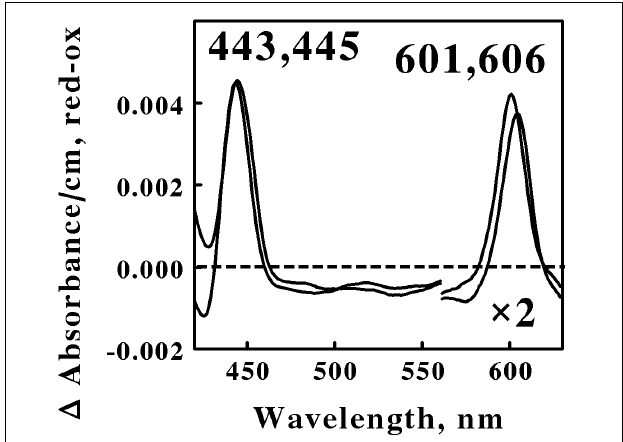
FIGURE 4 | Reduced minus oxidized difference spectra obtained when excess ferrous sulfate was mixed with intact cells of Acidiplasma aeolicum (lower wavelengths) and Ferroplasma acidiphilum (higher wavelengths), representing the Euryarchaeota. The number of cells present in 8 ml were 8.8 × 10 10 and 9.5 × 10 10 for A. aeolicum and F. acidiphilum , respectively. The absorbance values in the α β regions of both spectra were multiplied by 5 to aid in the clarity of